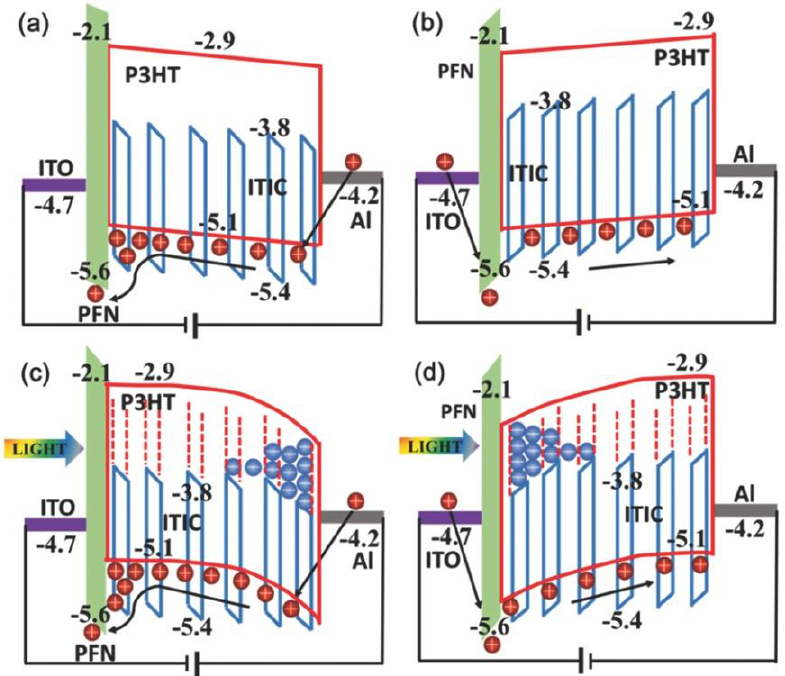
Figure 8. Schematic energy level diagram of the employed materials for the OPDs ( a , b ) under dark and ( c , d ) light illumination conditions: reverse bias ( a , c ), forward bias ( b , d ). (Reproduced with permission from [76]. WILEY Publishing, 2016).